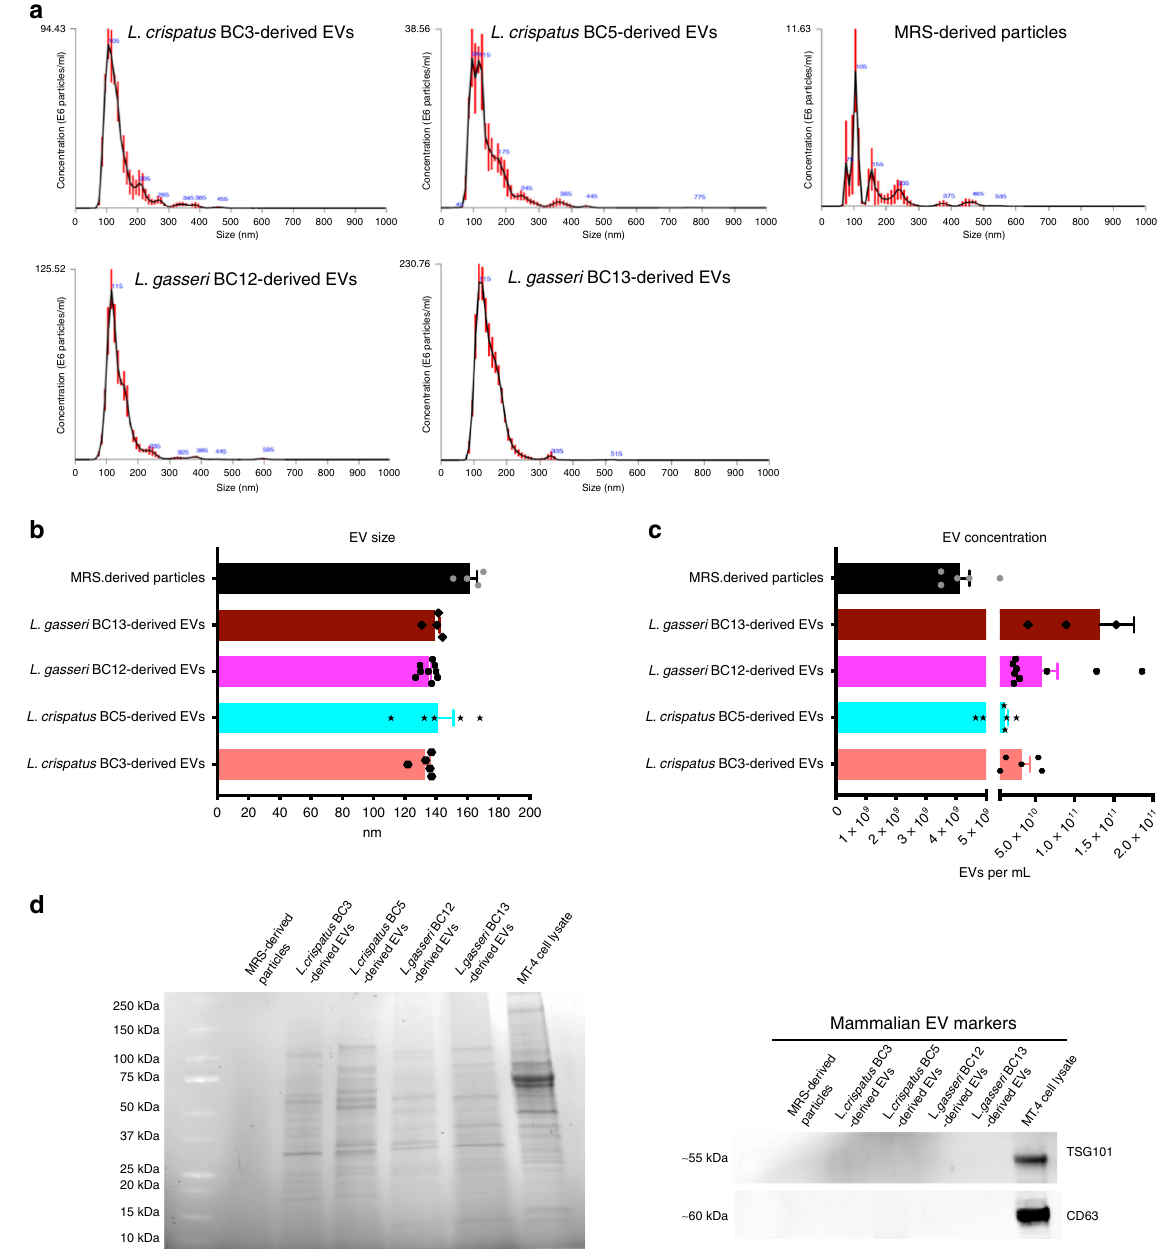
Fig. 1 Nanoparticle tracking analysis of Lactobacillus -derived EVs. Nanoparticle tracking analysis of EVs released by L. crispatus BC3, L crispatus BC5, L. gasseri BC12, and L. gasseri BC13 and of particles present in MRS culture medium. a Representative analysis of EV size and concentration in EV samples diluted 1:100 with PBS. b Mean± SEM of EV size (nm); c Mean ± SEM of EV concentration (particles per mL). Presented are the results of at least four independent measurements. d Proteins associated to Lactobacillus -derived EVs. Stain-free gel representing the spectrum of proteins obtained from EV lysates and absence of mammalian EV-associated proteins TSG101 and CD63. Source data are provided as a Source Data fi le.